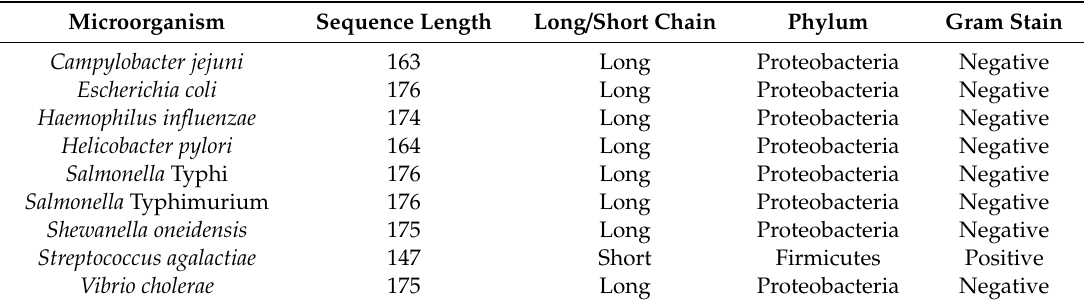
Table 3. Bacteria with flavodoxins that are essential for viability a